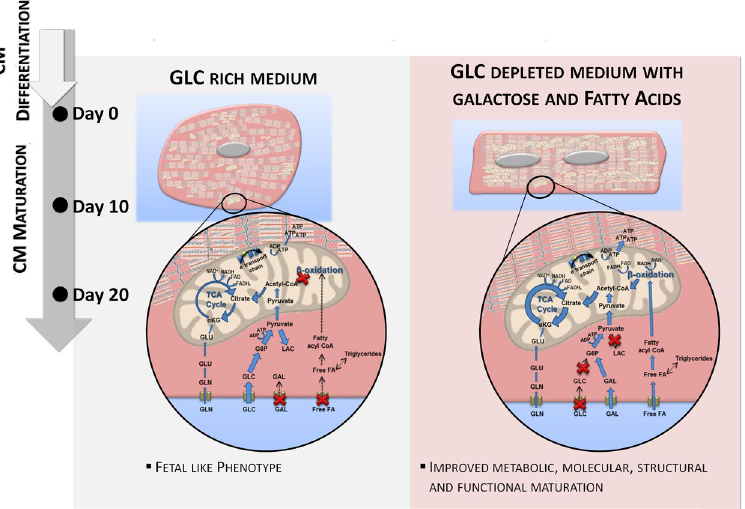
Figure 7. Summary of major findings in this study. The main differences in terms of cell phenotype and metabolism after 20 days of culture in GLCM and GFAM are